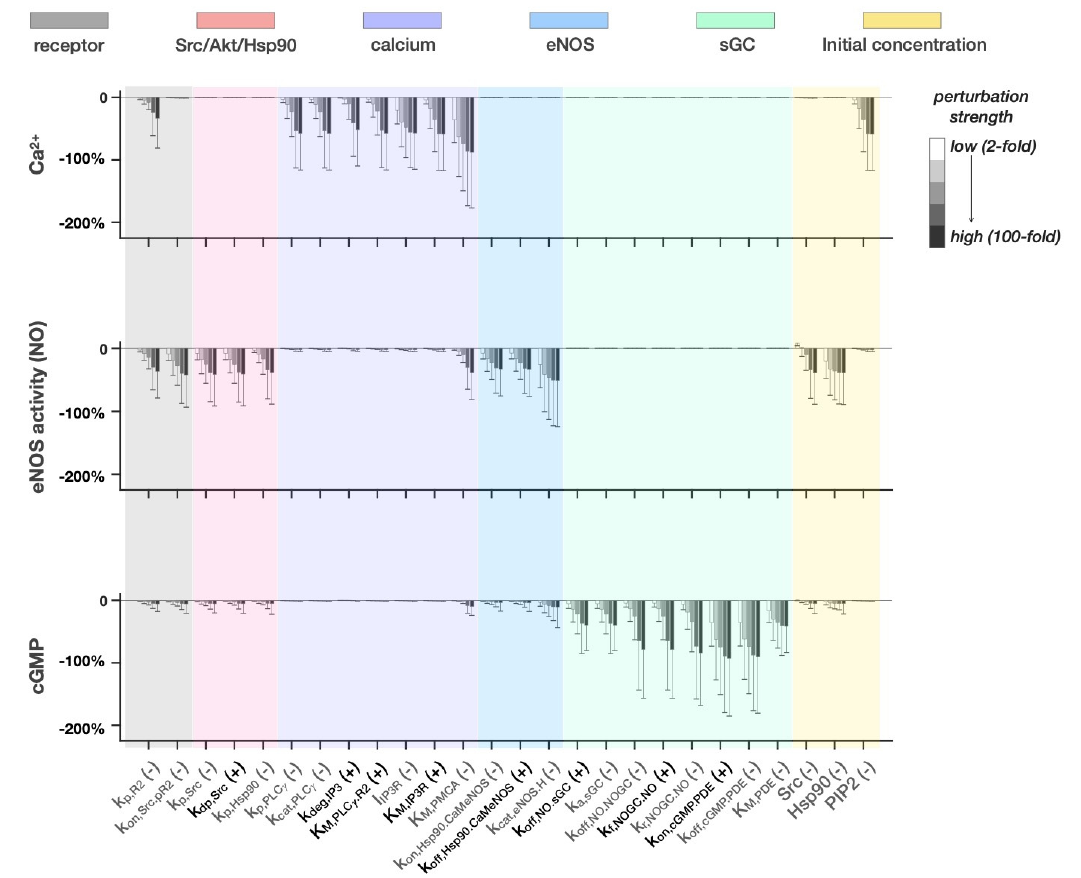
Figure 6. Effective perturbations in high VEGF condition. Perturbations shown are significantly effective in reducing the model output AUC levels by at least 10% compared to the baseline level. VEGF concentration is 0.389 nM and TSP1 concentration is 0 nM in all simulations. Bars: mean of model predictions using the 19 sets of best fit parameter values with six perturbation levels (scaling parameters by 2- to -100-fold). Error bars: standard deviation of 19 sets of simulations. Shaded areas: modules where the perturbed parameter takes effect. (+) sign with black font: parameter was increased using the left panel Hill function in Figure 3; (-) sign with gray font: parameter was decreased using the right panel Hill function in Figure 3.